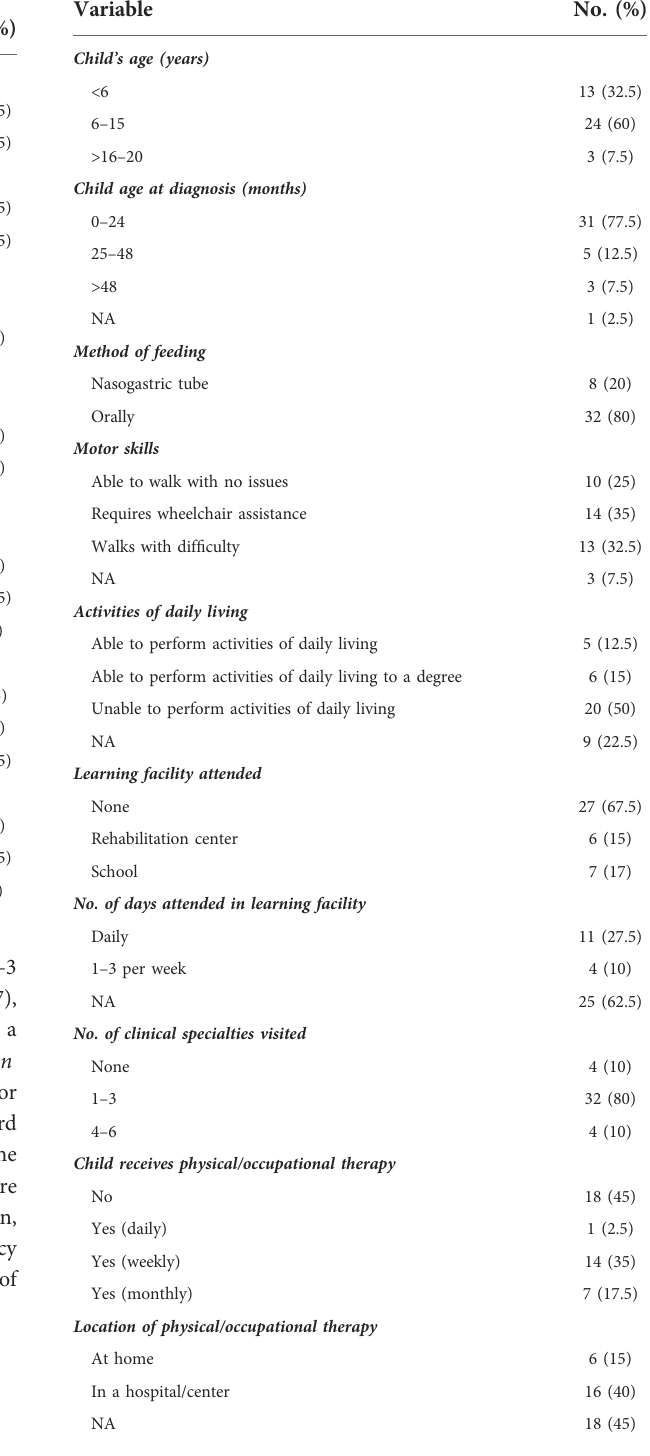
TABLE 1 Distribution of the participant parents according to their characters, overall number of children and number of those having CP.